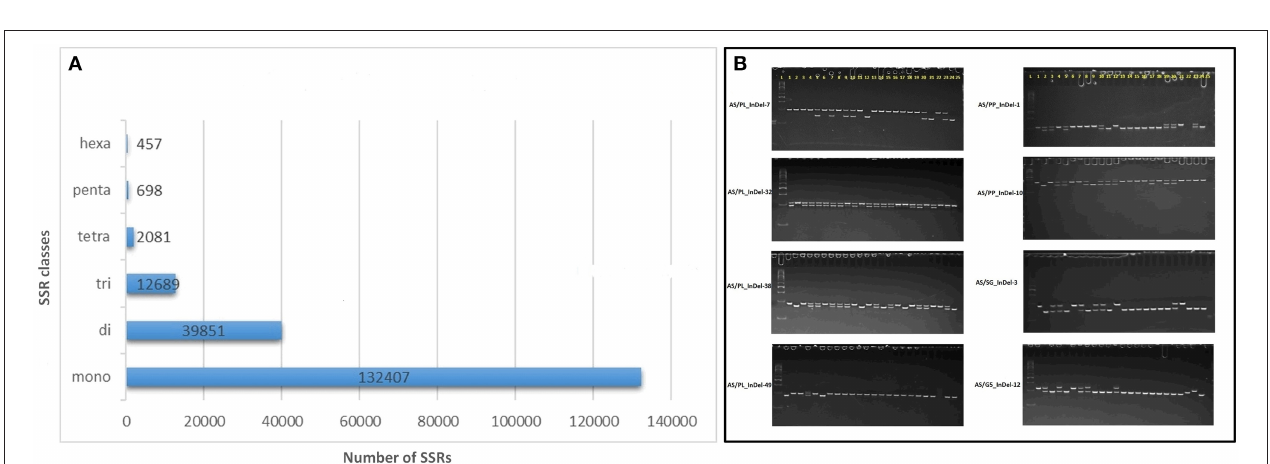
FIGURE 4 | Genomic simple sequence repeat (SSR) and EST-insertion-deletion (InDel) markers in guava genome. (A) SSR motif distribution in guava draft genome assembly as identified with the MIcroSAtellite (MISA) identification tool. (B) Subset of InDel-based amplicons amplified and separated by 6% polyacrylamid gel-based electrophoresis. #InDels tested and presented represents marker developed by comparative transcriptomics of AS, Allahabad Safeda; PL, Purple Local; PP, Punjab Pink; SG/L-49, Sardar Guava/Lucknow-49; G5, Apple-Colored-CISH-G5/Lalima. L represents 50-bp DNA ladder on the left and 25 lanes represent (1) Purple Local (2) Lucknow-49/Sardar Guava (3) Shweta (4) Hisar Safeda (5) Punjab Safeda (6) VNR Bihi (7) Seedless (8) Hisar Surkha (9) Punjab Pink (10) Punjab Kiran (11) Lalit (12) Portugal (13) CISH-G5/Lalima (14) AC-62/ Punjab Apple Guava (15) AC-107 (16) AC-14 (17) Arka Kiran (18) CISH-G1 (19) HB-88 (20)17-16 (21) Lemon guava (22) Strawberry guava (23) Arka Amulya (24) Allahabad Safeda and (25) No DNA template